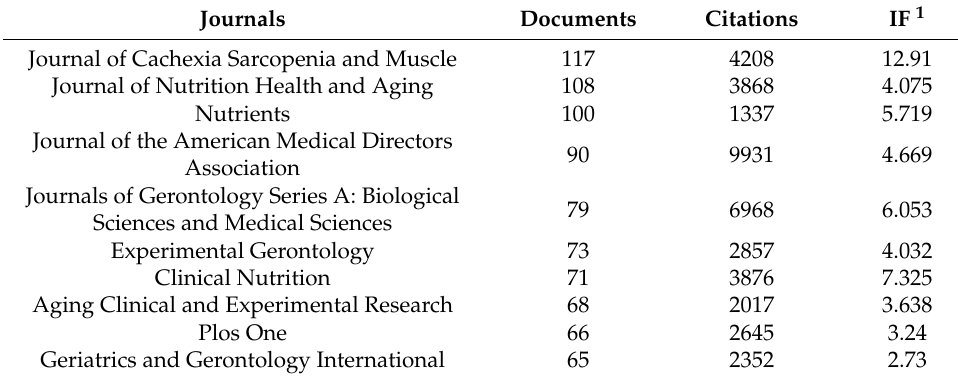
Table 1. The top 10 most active journals in the sarcopenia research